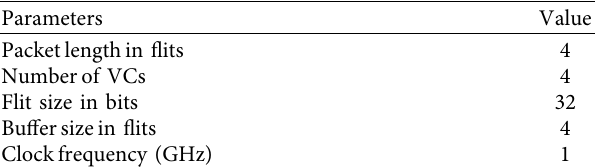
Table 2: Parameters used in the